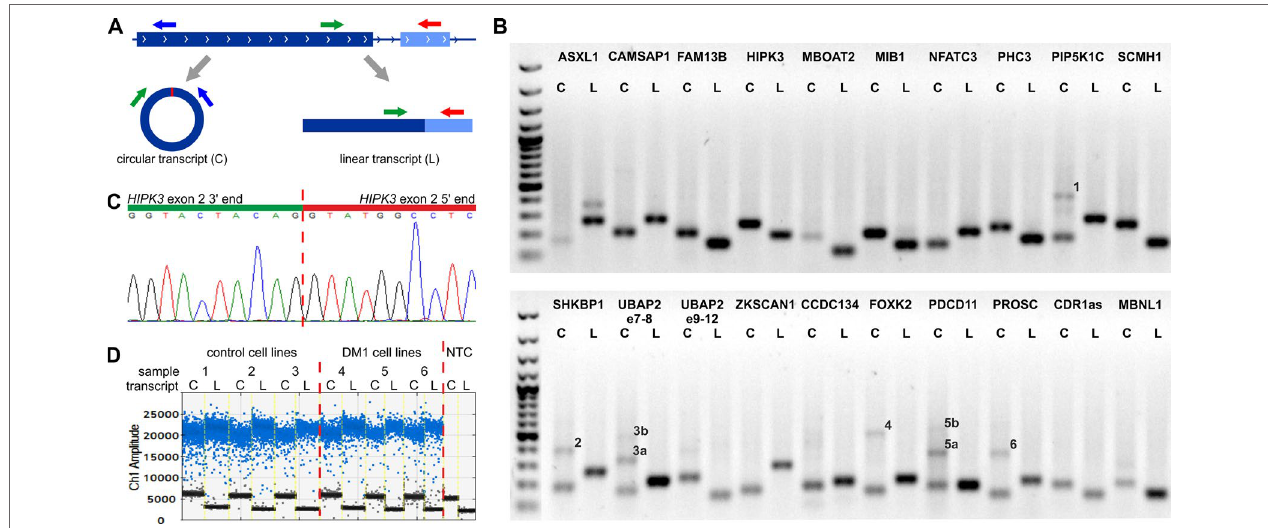
FIGURE 1 | Design and validation of the assays used for analysis of circRNA levels. (A) Each assay consisted of three primers as follows: one primer (green arrow) common to the circular (C) and linear (L) transcripts (circRNA and mRNA, respectively) and two primers specific for either circular (blue arrow) or linear (red arrow) transcripts. The primers specific to linear transcripts were located in either the downstream or upstream exon, outside of circRNA-coding exons. (B) Gel electrophoresis confirming the size of circRNA-specific (C) and linear, mRNA-specific (L) amplicons. Additional bands in some tracks corresponding to circRNAs indicate the occurrence of circRNA-related concatemers (see You et al., 2015), labeled by numbers on the gel. The expected lengths of the indicated concatemers are: 1–427 bp, 2–383 bp, 3a–314 bp, 3b–473 bp, 4–498 bp, 5a–357 bp, 5b–537 bp, and 6–360 bp. An additional band in ASXL1 linear transcript track corresponds to the alternative transcript containing alternatively included (97-nt long) exon 5. The first track is the GeneRuler 1-kb DNA Ladder (Thermo Fisher Scientific, Waltham, MA, USA). PCR reaction was performed for a control CL sample from CL_DM1 sample set. (C) Exemplary result of Sanger sequencing of the predicted back-splice site of circHIPK3. Results of sequencing of back-splice sites of other circRNAs are shown in Figure S2 . (D) Exemplary result of the ddPCR analysis of circHIPK3 in the myoblast CL (CL_DM1) sample set. Sample number and type are indicated above the graph. NTC—no template control. Ch1 Amplitude—relative fluorescence signal in channel 1. Each blue dot represents one copy of either circular or linear transcript (positive droplets), while the black dots represent negative (empty) droplets. For each sample, the number of positive and negative droplets was used to calculate the concentration of the analyzed